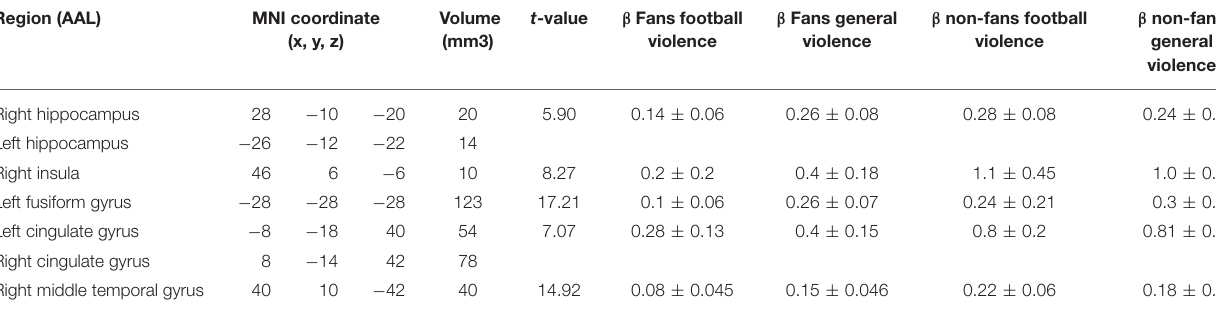
TABLE 1 | Contrast results. Region